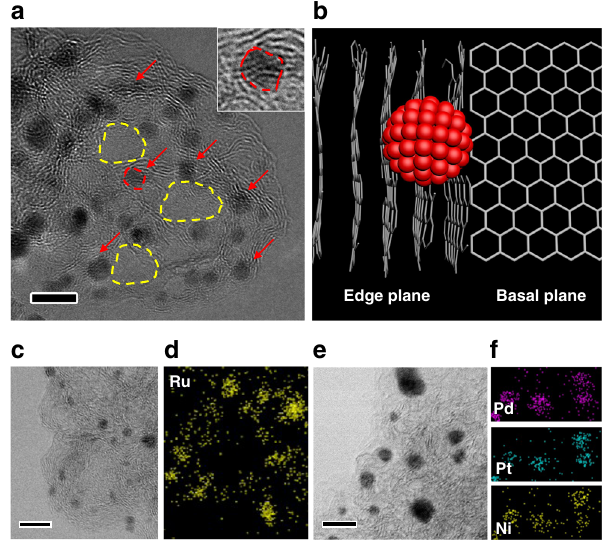
Fig. 5 The HRTEM and STEM characterization of single element and multielement nanoparticles on the Joule heated S-CNFs. a The HRTEM image of Pt nanoparticles located on edge planes (marked by the red arrows). The carbon basal planes are marked as the yellow dashed circles. The inset shows an enlarged view of a nanoparticle (marked by the red dashed area). b Schematic represents a nanoparticle that is reside on edge plane instead of basal plane in T-graphite. c The ABF-STEM image shows Ru nanoparticles on edge planes, and d the corresponding EDS mapping. e The ABF-STEM image of ternary PdPtNi nanoparticles on edge planes and f the corresponding EDS mapping. All scale bars are 5